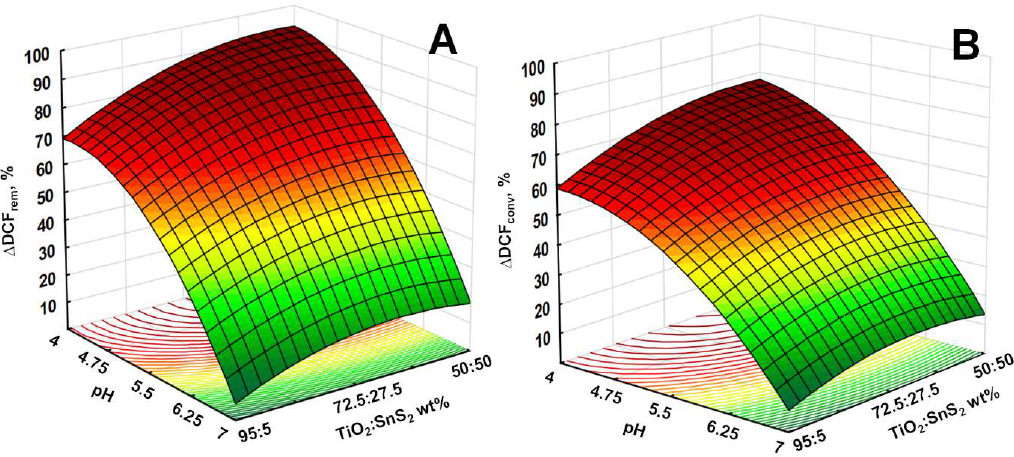
Figure 9. 3D response surface and contour diagrams showing the effects of the mutual interactions of initial pH and SnS 2 wt % on the transformed values of DCF removal ( A ) and conversion ( B ) by solar/TiO 2 -SnS 2 -HT.